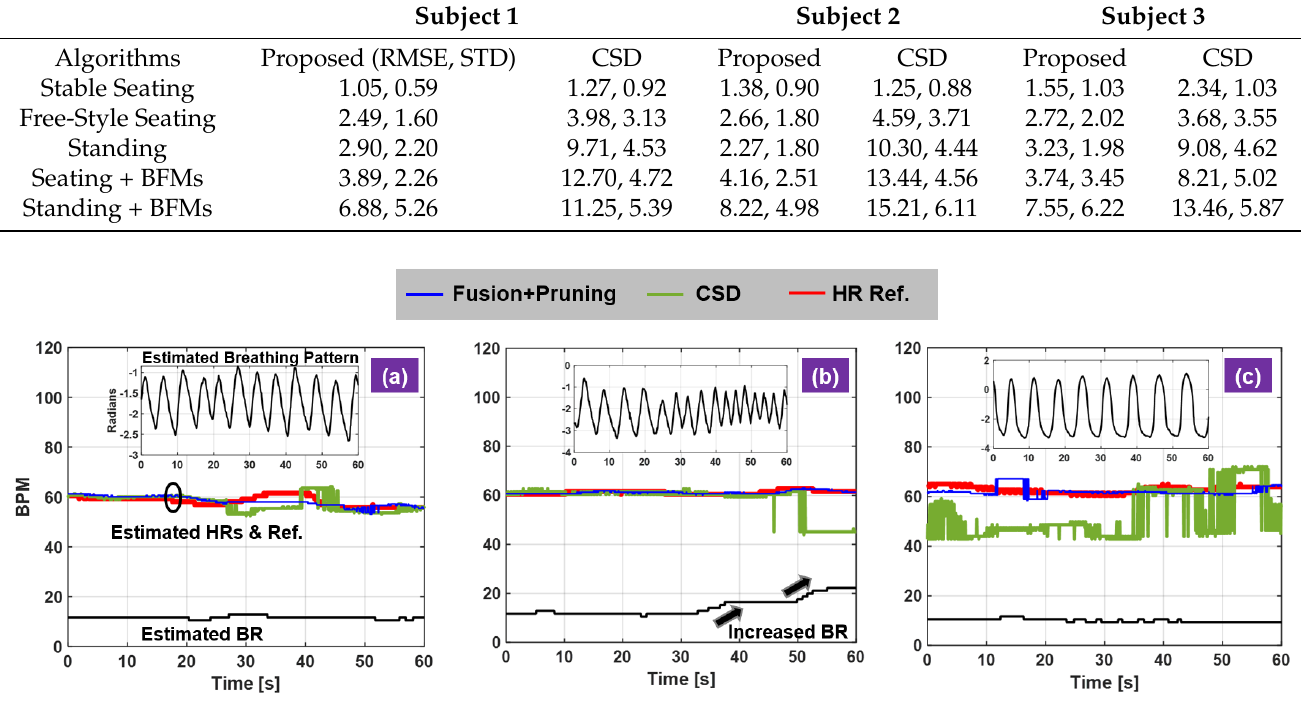
Figure 8. Investigation of dynamic breathing profiles on HR monitoring. ( a ) consistent shallow breathing; ( b ) varying regular breathing; ( c ) deep breathing.